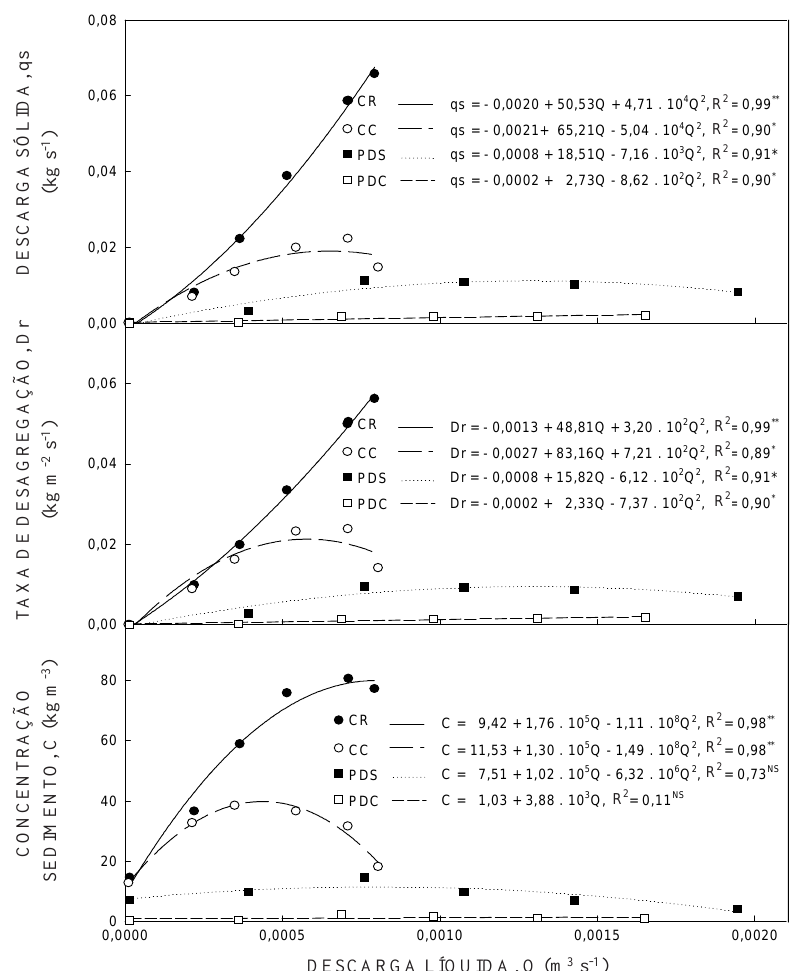
Figura 1. Descarga sólida (qs), taxa de desagregação em sulcos (Dr), concentração de sedimento (C) e descarga líquida (Q), considerando diferentes preparos e consolidação do solo (CR = convencional recente, CC = convencional consolidado, PDS = plantio direto sem palha, PDC = plantio direto com palha). ** = significativo (P < 0,01); * = significativo (P < 0,05); NS =